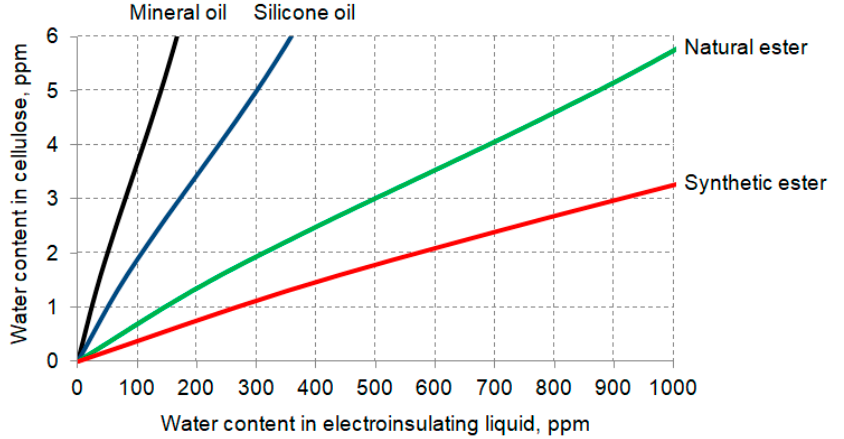
Figure 3. Comparison of moisture equilibrium curves for cellulose impregnated with different electroinsulating liquids, for temperature equal to 70 ◦ C; based on data from [44].